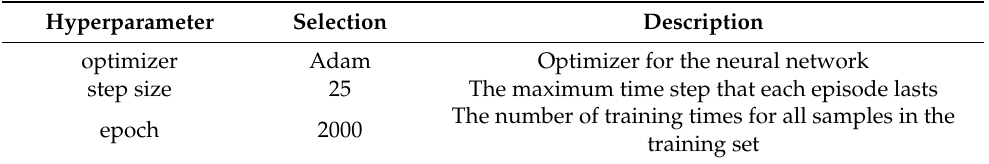
Table 1. The hyperparameter settings of the neural network.